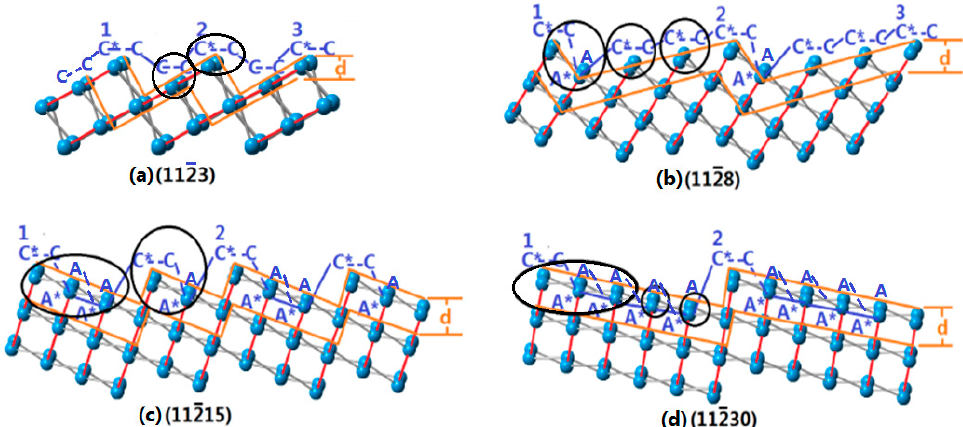
Figure 10. Atomic structures and types of surface atoms of the other crystal planes in Part A: ( a ) (1 1 − 2 3); ( b ) (1 1 − 2 8); ( c ) (1 1 − 2 15); ( d ) (1 1 − 2 30). ( a ) (1 1 − 2 3); ( b ) (1 1 − 2 8); ( c ) (1 1 − 2 15); ( d ) (1 1 − 2